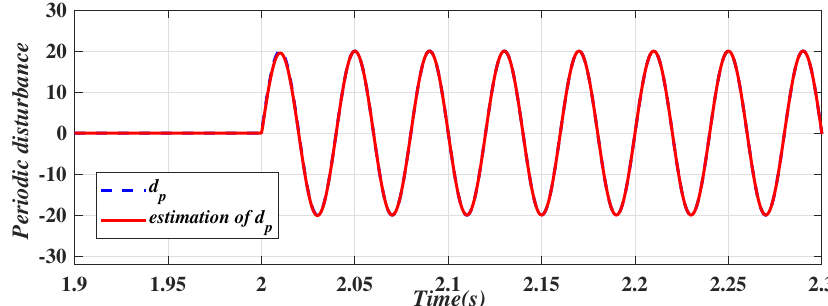
Figure 5. Periodic disturbance and estimation of periodic disturbance.